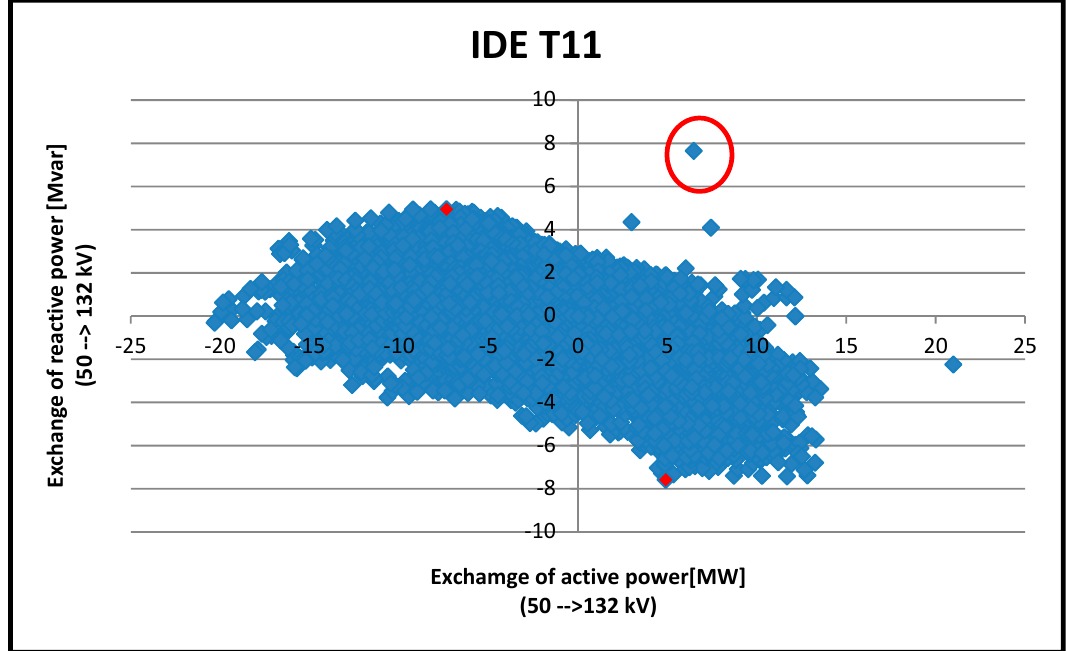
Figure 4 . Scatter plot for the substation IDE T11 132/50 kV. The red circle highlights the discarded data points.